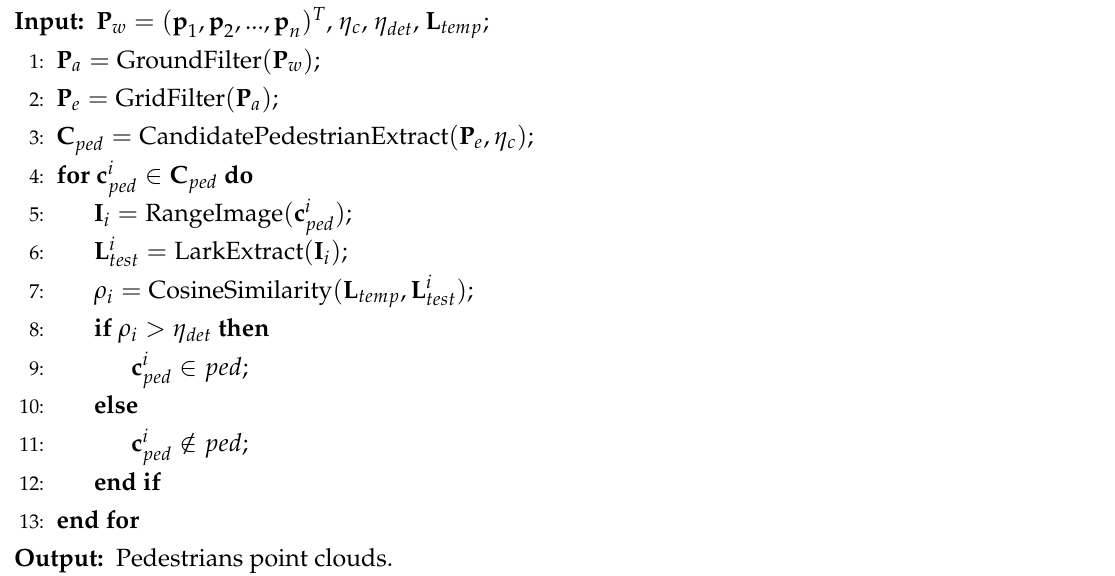
Algorithm 2 Pedestrian-detection method based on single